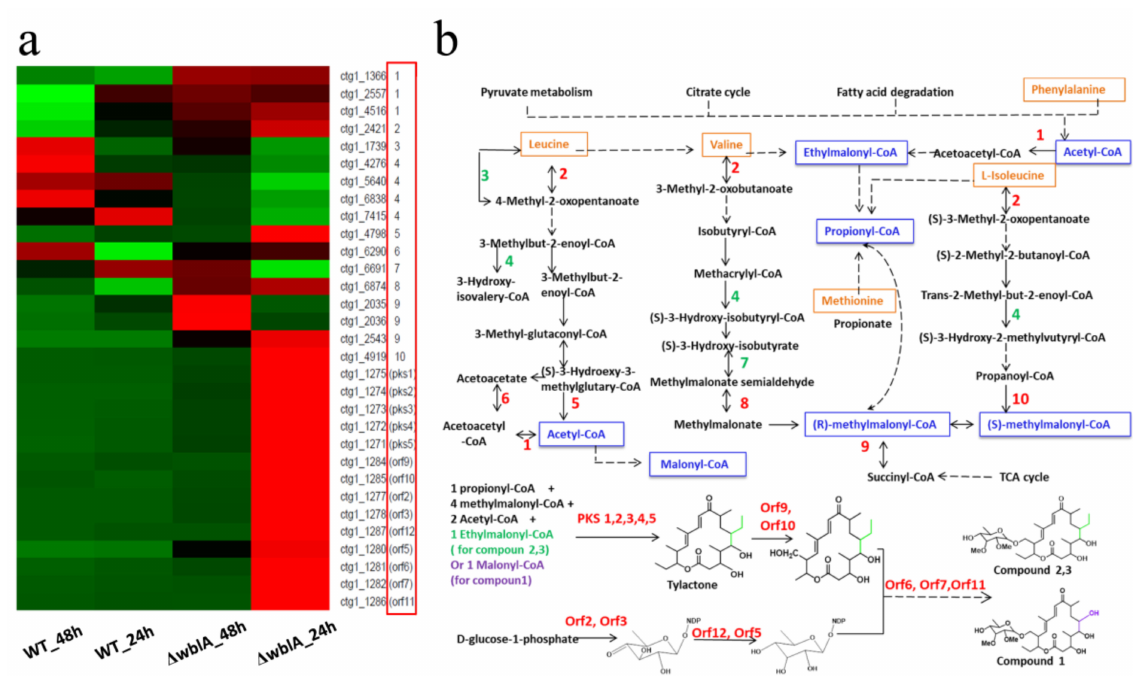
Figure 3. Differentially expressed genes in tylosin analogue compounds (TACs) biosynthesis in WT and ∆ wblA. ( a ) Analysis of significantly expressed genes in both WT and ∆ wblA at 24 h and 48 h. |log2FC| ≥ 1 and p adjust < 0.001. Expression variance for each gene was indicated by different colors: red (up-regulated genes), green (down-regulated genes) and black (|log2FC| < 1). The numbers or gene names in the red box are corresponding to the catalytic reaction steps involved in ( b ). ( b ) Proposed pathway diagram of TACs biosynthesis and the relevant amino acids catabolism. The blue boxes represent the precursors that incorporated into tylactone, and the orange boxes represent the precursors derived from the catabolism of five amino acids. The numbers 1–10 denote differentially expressed genes in 10 reaction steps of deduced KEGG pathway. Green numbers denote down-regulated genes encoding enzymes responsible for these reaction steps, red numbers denote up-regulated genes encoding enzymes responsible for these reaction steps. Dotted arrows represent multiple genes responsible for these reaction